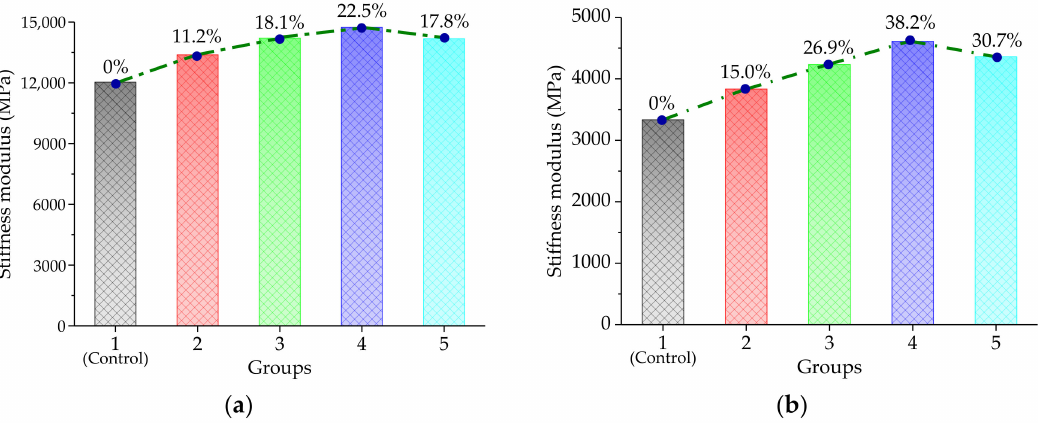
Figure 9. Low-temperature indirect tensile stiffness modulus test results: ( a ) At 5 ◦ C; and ( b ) at 20 ◦ C.